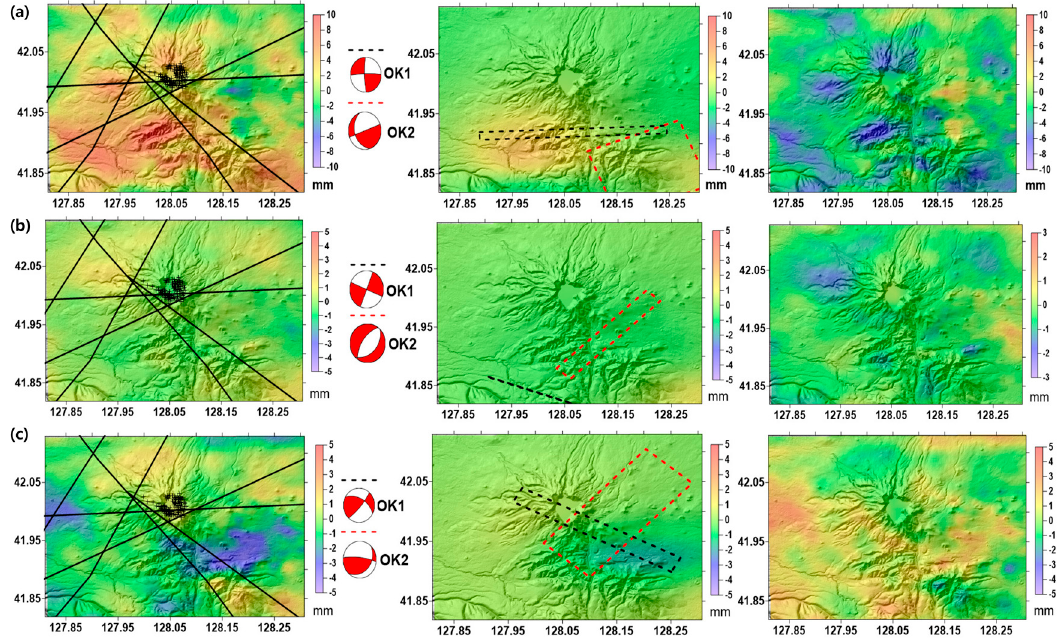
Figure 13. Deformation extracted by StaMPS/MTI observations ( left column ), modelling with two Okada models ( middle column ) and error residuals for three time periods ( right column ) ( a ) 2007/08/31–2007/12/14, ( b ) 2008/03/28–2008/05/02 and ( c ) 2010/02/26–2010/04/02 (top to bottom).